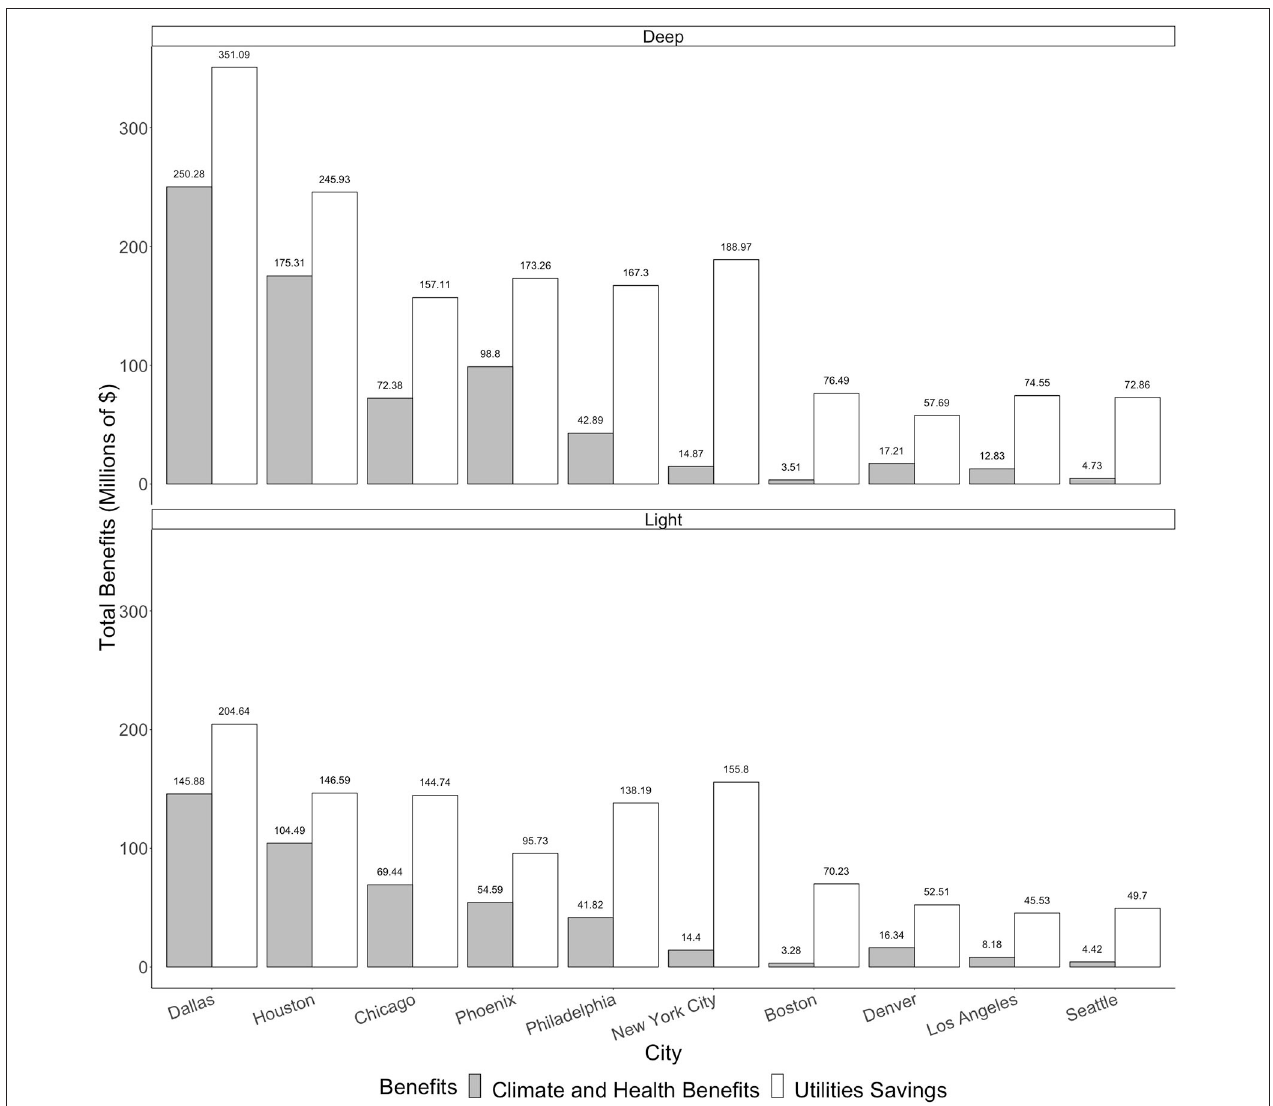
FIGURE 5 | Total estimated climate and health (gray) or utility (white) benefits (million 2016 USD) under light (top) or deep (bottom) heat adaptation retrofits applied to detached single-family residential buildings built from 1990 to